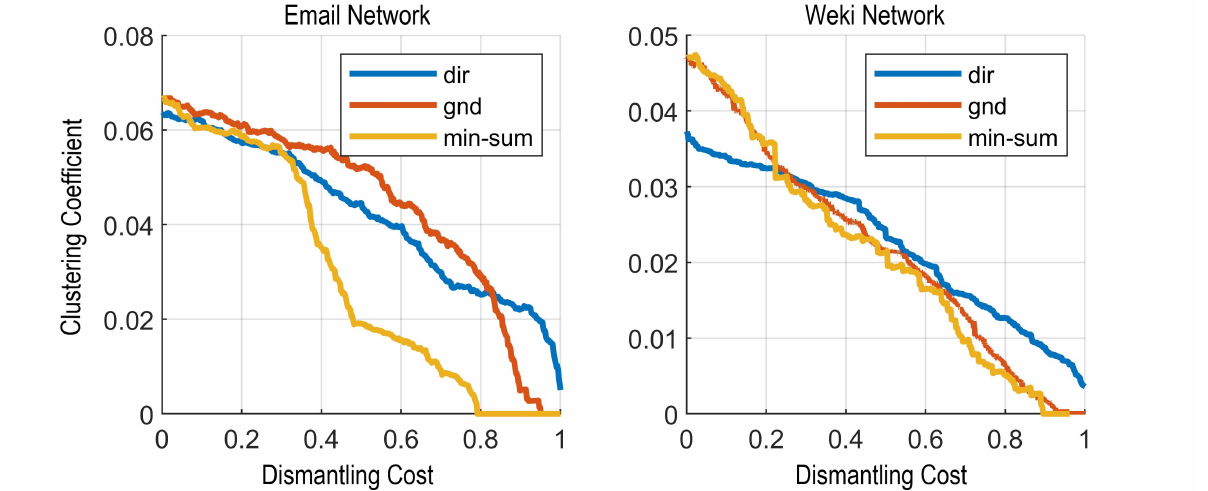
Figure 5. Curve graph of real network disassembly cost and clustering